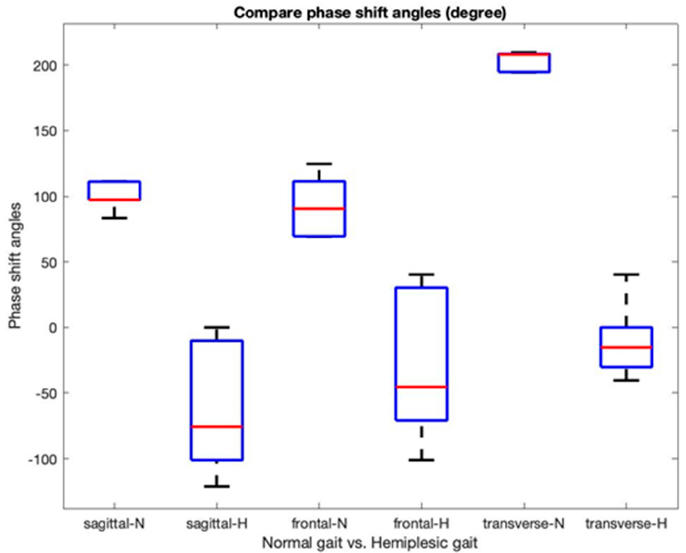
Figure 7. The normalized gait phase diagrams of the hip and knee joint angles of Figure 5 (i.e., hip-sagittal vs. knee-sagittal).